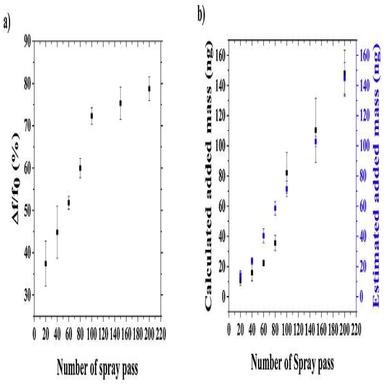
Dependency of relative frequency shift (a) and added mass (b) on number of spray passes.